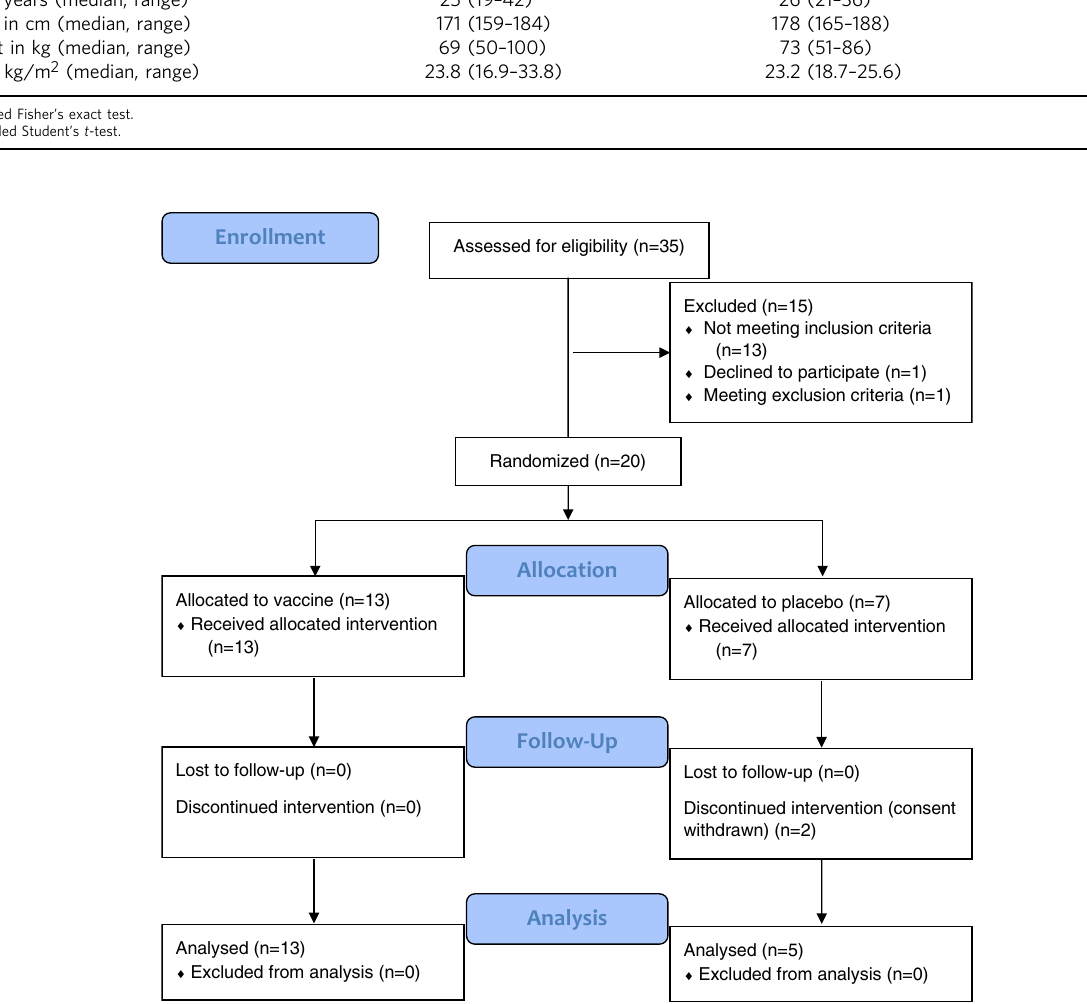
Fig. 2 Study fl ow chart. CONSORT fl ow diagram showing study participant fl ow through for each individual stage of the randomized controlled vaccination trial (enrollment, allocation, follow-up, and